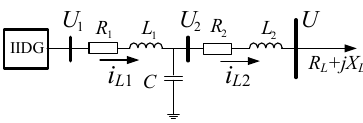
Figure 3. Structure diagram of an IIDG system.